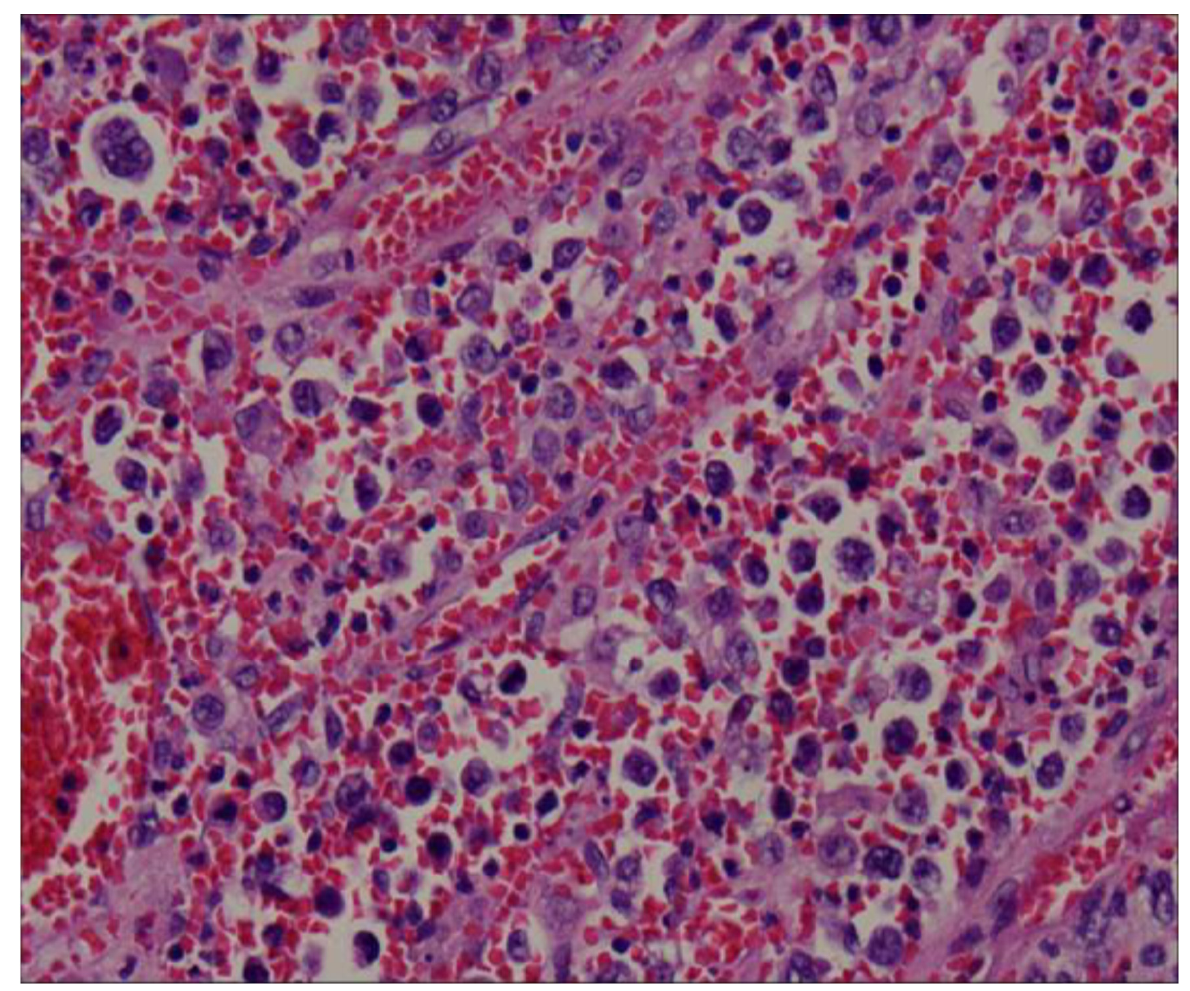
Figure 4. The histology revealed a diffuse proliferation of a monotonous population of large neoplastic lymphoid cells and extensive necrosis.